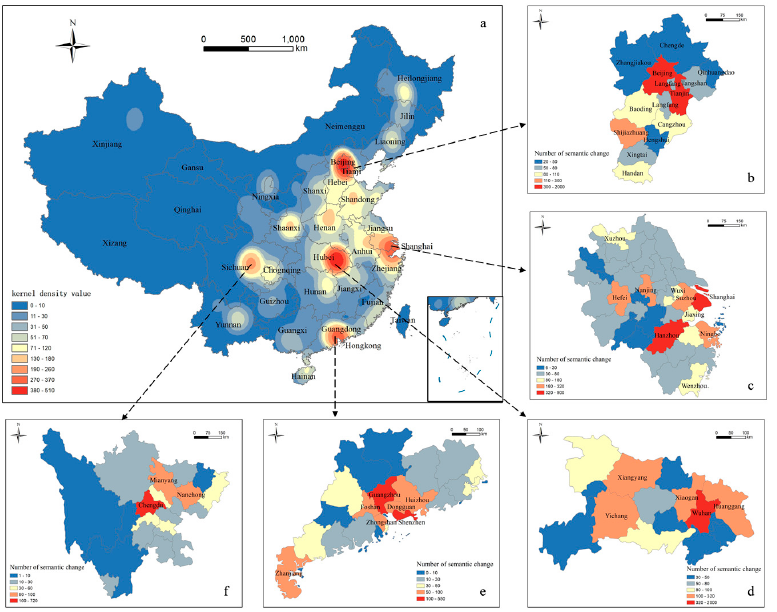
Figure 11. The spatial distribution of COVID-19-related semantic change events. Sub-figures ( a – f ) show the kernel density of semantic change events in: ( a ) China; ( b ) Beijing–Tianjin–Hebei region; ( c ) Yangtze River Delta region; ( d ) Hubei Province; ( e ) Guangdong Province; ( f ) Sichuan Province.